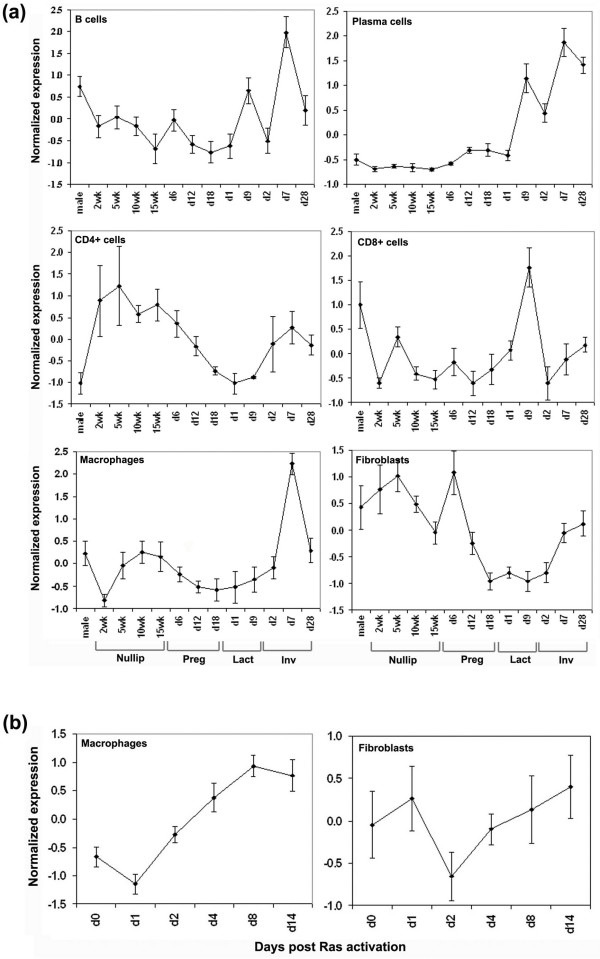
Estimated changes in the relative abundance of stromal cell types. Calculated relative abundance (mean ± SEM) of stromal cell types (a) during mammary gland development or (b) following oncogenic Ras activation. Expression levels shown are the average of normalized expression levels of the tissue-specific genes for each tissue/cell type listed in Table 1.